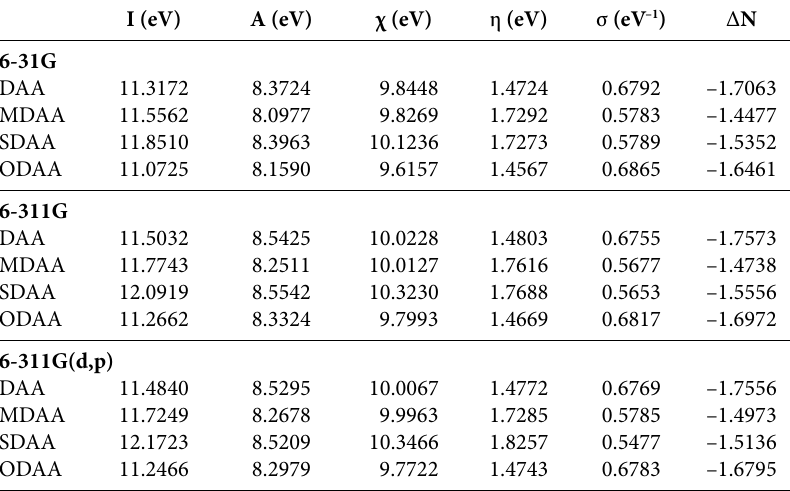
Table 4: Calculated quantum chemical descriptors for protonated molecules in gas